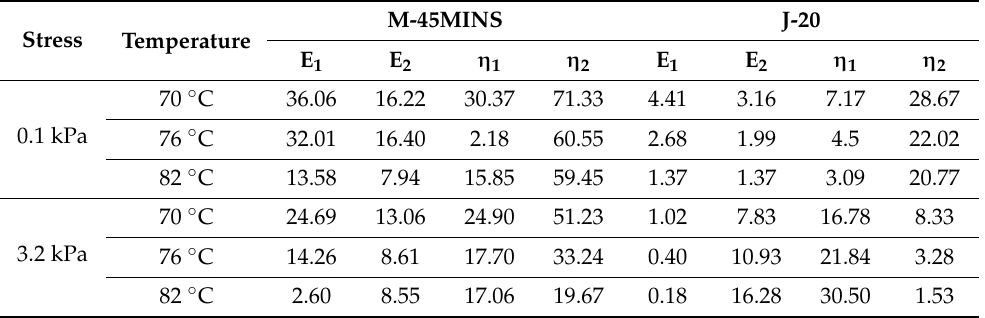
Table 5. Burgers’ model